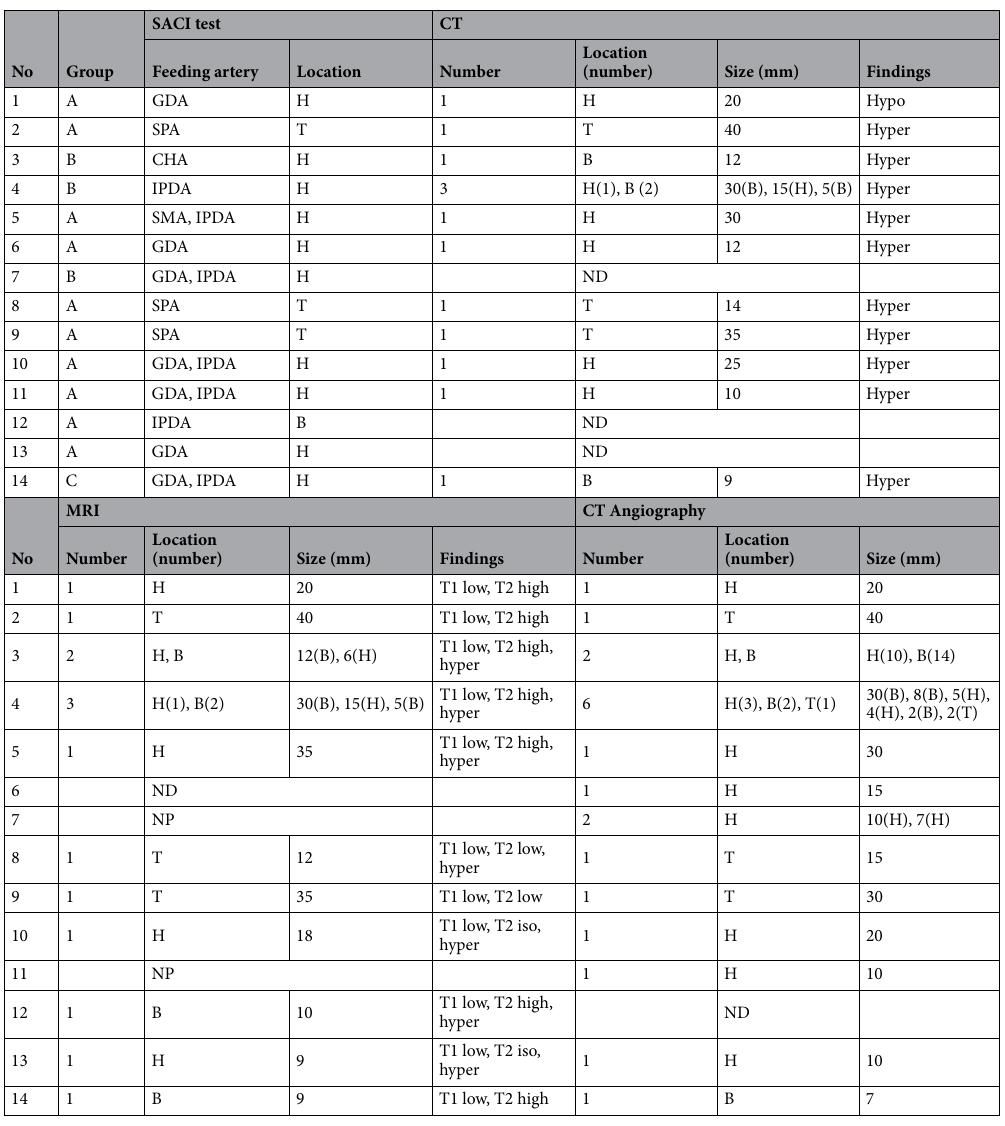
Table 2. Results of preoperative imaging studies (N = 14). B body, CT computed tomography, GDA gastroduodenal artery, H head; hyper: hypervascular, hypo hypovascular, IPDA inferior pancreatoduodenal artery, MRI magnetic resonance imaging, ND not detected, NP not performed, SACI selective arterial calcium injection, SMA superior mesenteric artery, SPA splenic artery, T